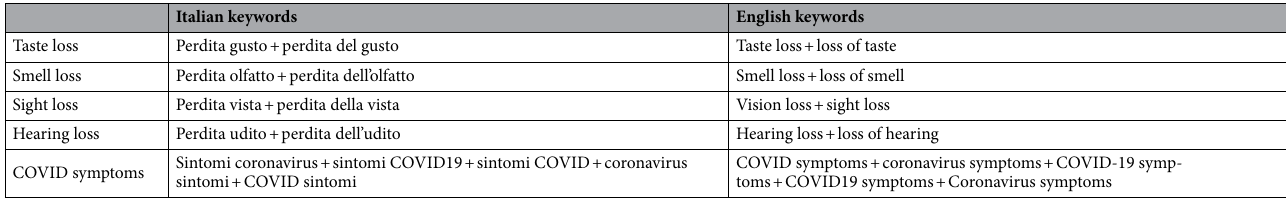
Table 1. Search terms used for searches in Italian and English on Google Trends. The first column is the reference keyword used to summarize the corresponding searches in the main text. The “ +” character allows one to sum up data for multiple searches with a logical